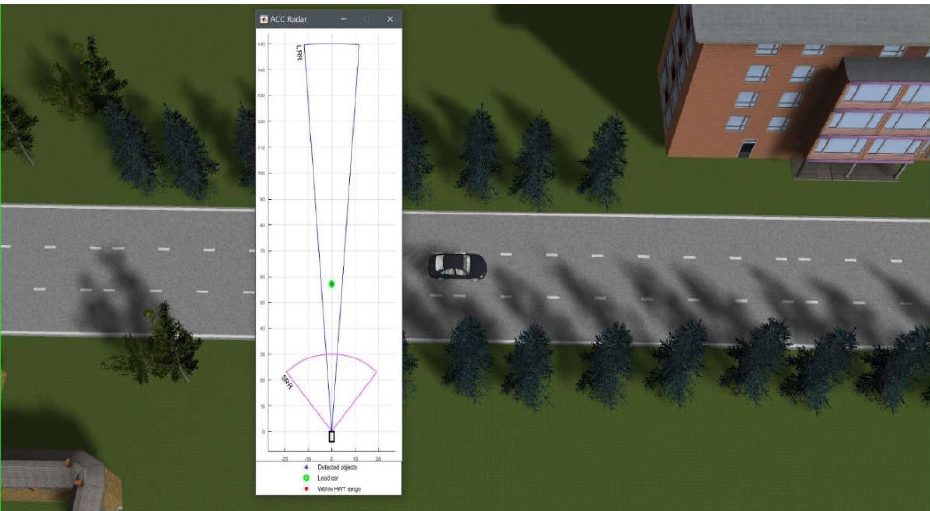
Figure 10. Vehicle A with TIS sensors in PreScan.